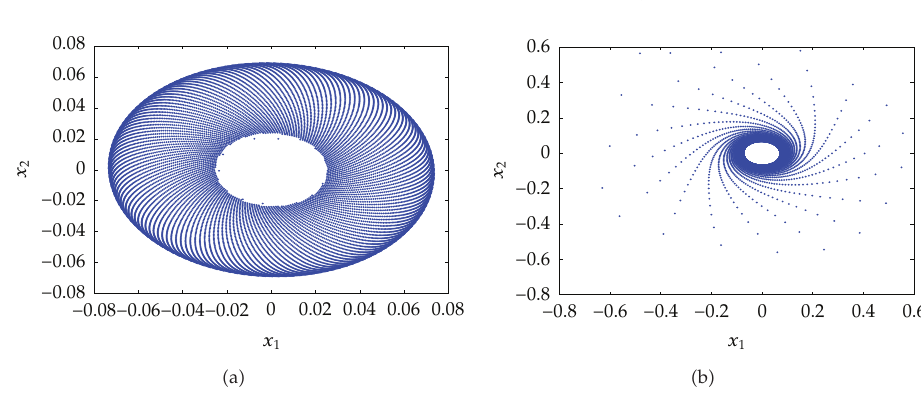
Figure 2: (cid:4) a (cid:6) Phase plot in space (cid:4) x 1 ,x 2 (cid:6) for system (cid:4) 4.1 (cid:6) with initial condition (cid:4) 0.02,0.02 (cid:6) and d 1 (cid:7) 0 . 85. (cid:4) b (cid:6) Phase plot in space (cid:4) x